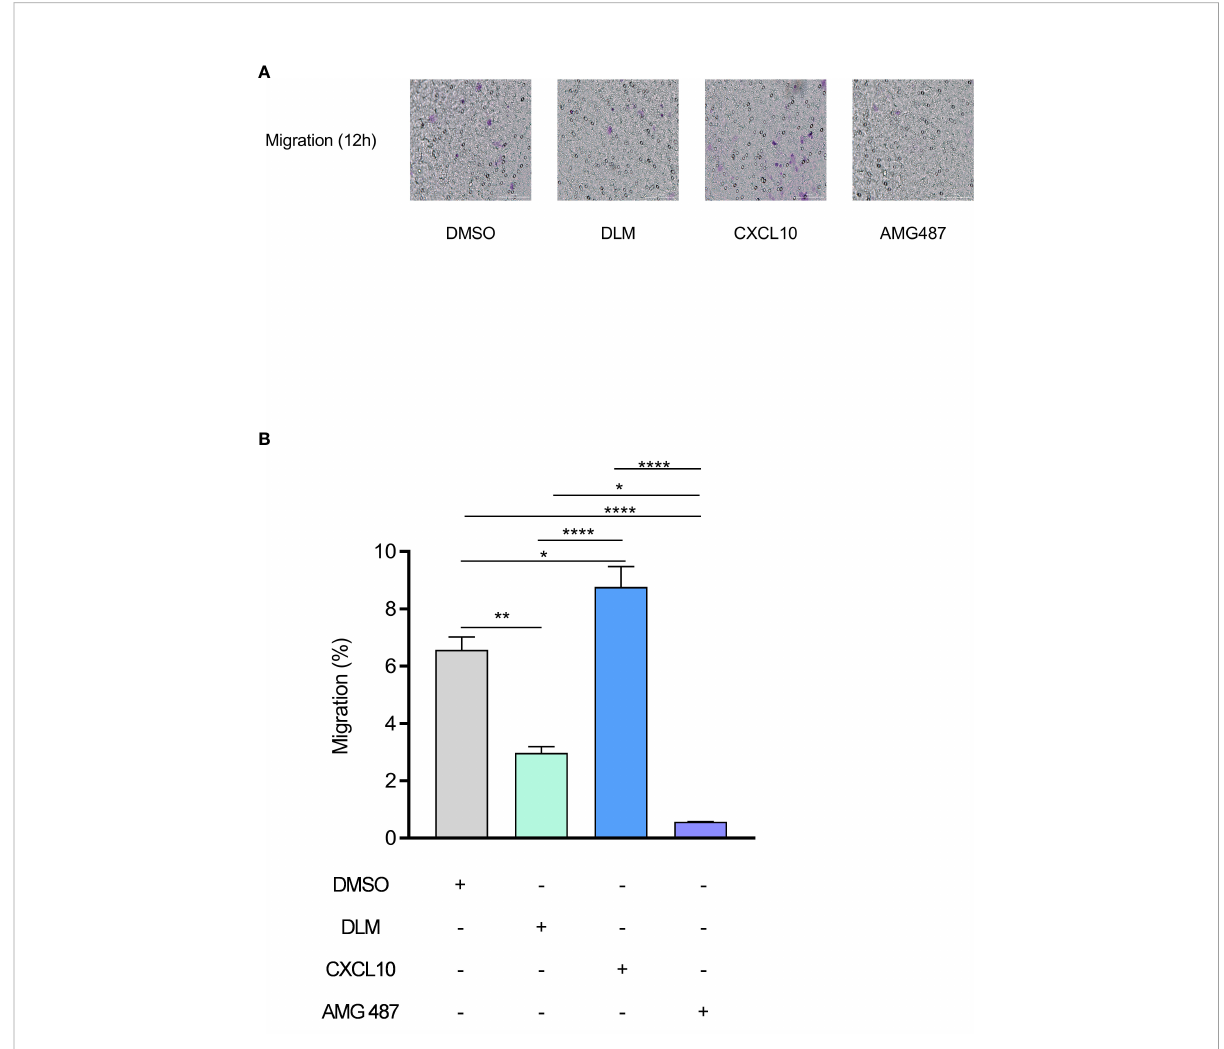
FIGURE 4 DLM inhibits the migration of PBMC by suppressing CXCL10 expression. Macrophages were pretreated with DMSO, DLM, CXCL10 and AMG487 for 24 h respectively to compare the in fl uence on migratory ability of PBMC. The purple dots in the image indicate the migrated cells. Number of migrated PBMC by group (objective ×20) (A) . PBMC migration rate of each group (B) . Data are presented as mean ± SEM. * p <.05, ** p <.01, and **** p <.0001 (two-way ANOVA). Results are representatives from at least three independent